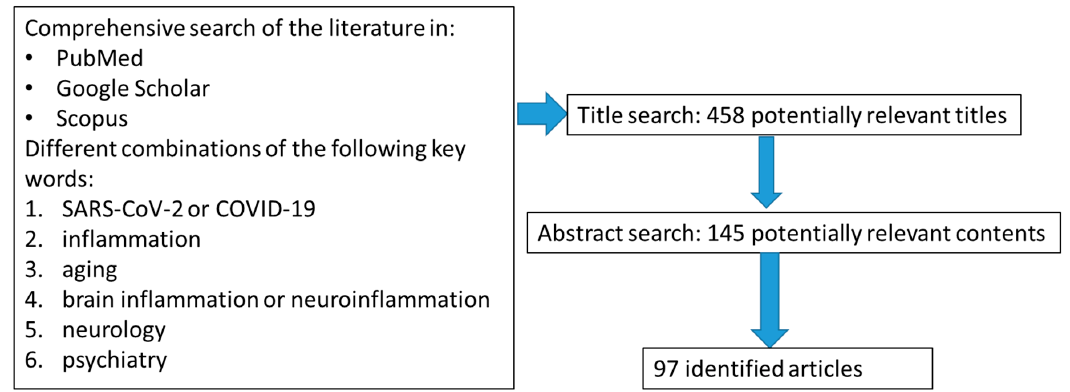
Figure 1. Summary of the consulted and identified scientific articles: selection strategy.